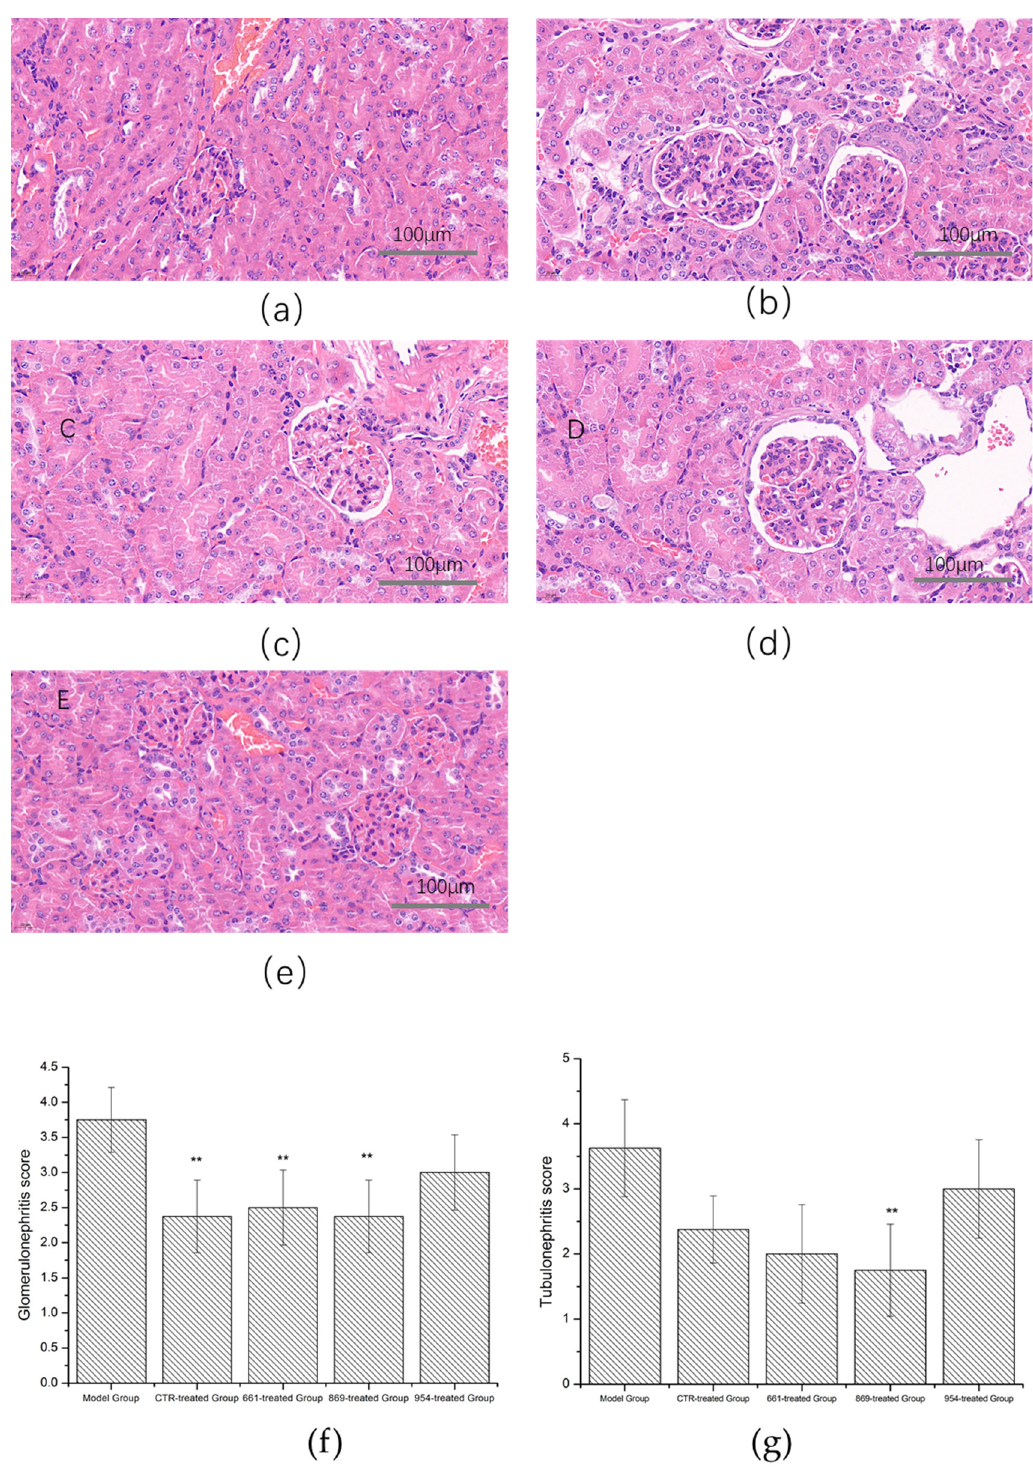
Figure 5. Renal pathological sections examination. ( a ). Model control group; ( b ). CTR-nanoflower- treated group; ( c ). IRS-661-nanoflower-treated group; ( d ). IRS-869-nanoflower-treated group; ( e ). IRS-954-nanoflower-treated group; ( f ). glomerulonephritis score; ( g ). tubular nephritis score (**: compared with the model control group, p < 0.01).